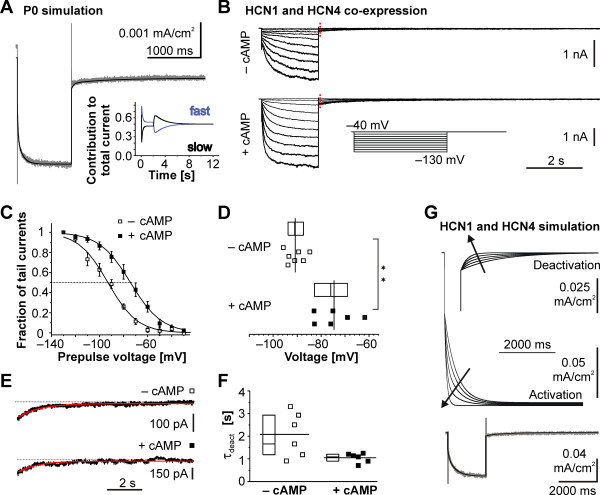
Simulation ofIhproperties and co-expression of HCN1 and HCN4 subunits in HEK293 cells. (A) The simulated combination of a fast- and a slow-activating HCN subunit replicates the characteristic kinetic properties (fast activation and slow deactivation) at P0. Simulation of Ih conducted by a fast- and slow-activating HCN subunit (black trace) elicited by a −130 mV step for 2 seconds (bottom) superimposed onto a trace obtained by the same voltage protocol in a neocortical neuron at P0 (grey trace). Inset: the kinetic behavior is explained by the time-dependent contribution of a fast (blue line) and a slow (black line) component. (B) Families of HCN1- and HCN4-mediated Ih recorded from HEK293 cells co-expressing these subunits. Currents in the absence (top) and presence (bottom) of cAMP were activated from a holding potential of −40 mV to command potentials between −40 and −130 mV of 2 seconds length (inset). Tail currents were recorded after stepping back to −40 mV and showed a slow deactivation and tail current amplitudes were measured at the time point indicated by the dotted red line. (C) Voltage sensitivity of HCN1 and HCN4 subunits co-expressed in HEK293 cells. Activation curves in the presence (closed box) and absence (open box) of cAMP are depicted as mean ± SEM. For illustration purposes the population means were fitted using a Boltzmann function. For evaluation of the voltage sensitivity individual neurons were considered (see D). Intracellular cAMP clearly shifted the half-maximal activation voltage by approximately 16 mV. (D) Population data on half-maximal activation voltage V1/2 for the HCN1 and HCN4 mediated Ih showed the marked difference (P <0.01) between experimental conditions without (top) and with (bottom) 100 μM intracellular cAMP. (E) Representative current deactivation of HCN1 and HCN4 co-expressing HEK cells (black) without (top) and with 100 μM cAMP (bottom) displayed with an overlay of a single exponential fit in red. (F) Population data on Ih deactivation kinetics in HCN1- and HCN4-expressing HEK293 cells without (left) and with (right) 100 μM intracellular cAMP. (G) Subunit ratio determines Ih kinetics. Simulation of different ratios of fast and slow HCN subunits with two independent first-order kinetic models. Displayed fractions of the fast subunit were (inside to outside - arrow direction) 0, 0.30, 0.60, 0.90 and 1.00, respectively. Bottom: The simulation (black trace) was experimentally supported by a co-expression of HCN1 and HCN4 (grey trace) in HEK293 cells as in (B) that showed similar results.